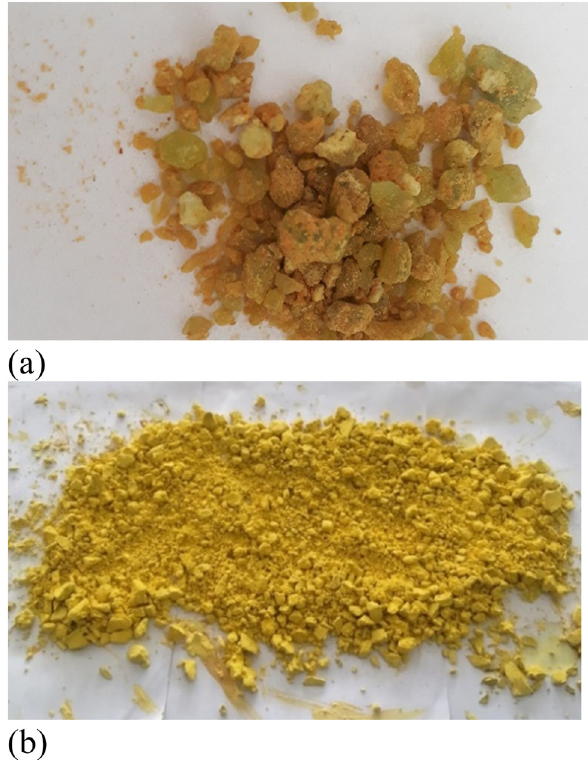
Figure 2: ( a ) FeSO 4 precursor and ( b ) pretreated yellow FeC 2 O 4 precursors.